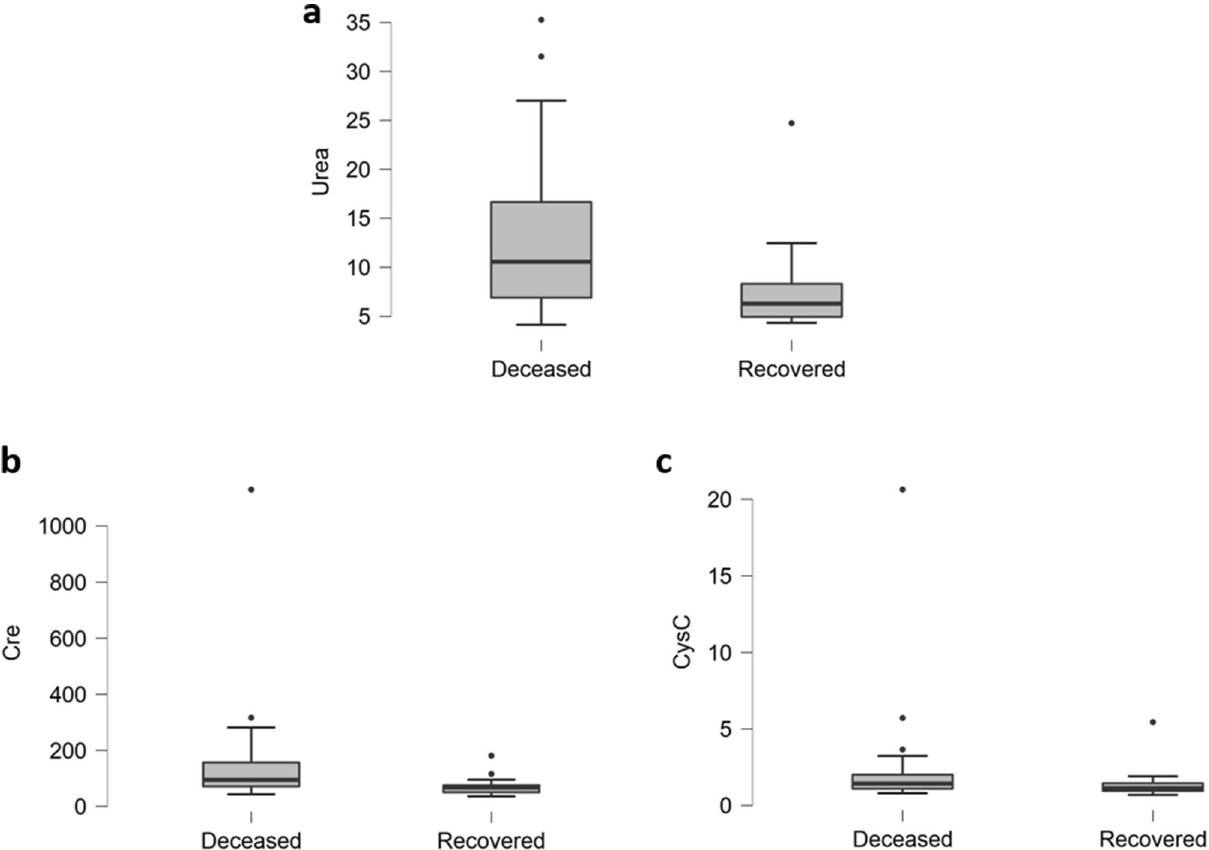
Figure 3. Comparison of renal biomarkers of deceased and recovered patients. ( a ) Urea is significantly increased, while Creatinine ( b ) and Cystatin C ( c ) are slightly elevated in deceased